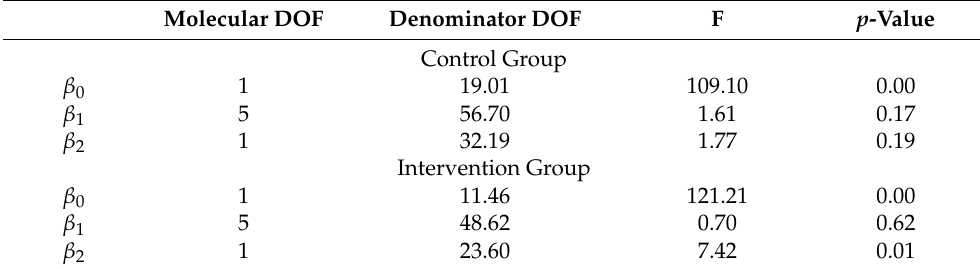
Table 2. Mixed Linear Model Test Results of the long-term effect. Molecular DOF Denominator